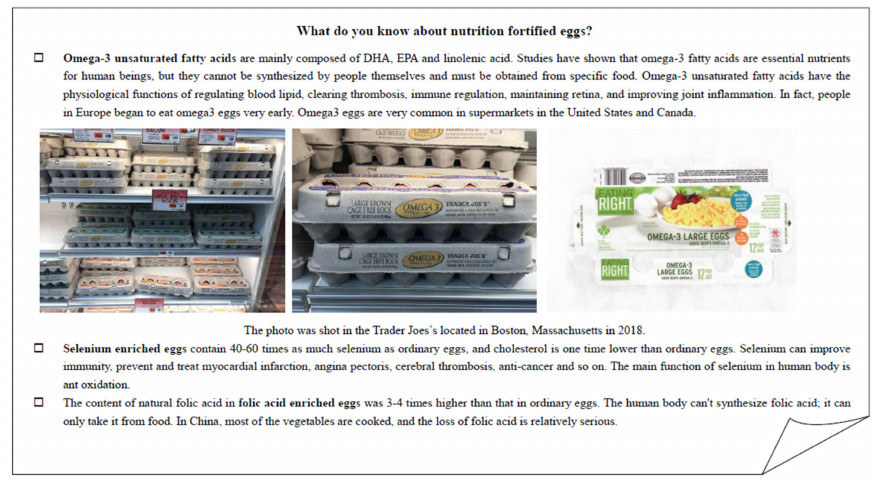
Figure 2. Information card shown to the treatment